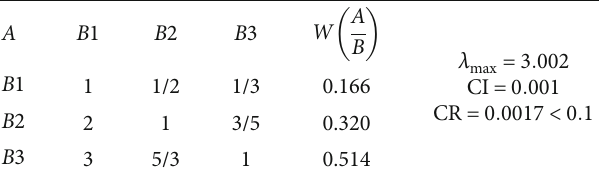
Table 2: Judgment matrix A ~ Bi ð i = 1 ~ 3 Þ .